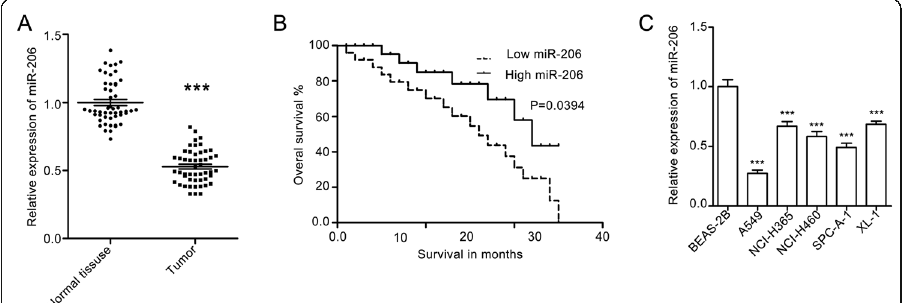
Fig. 1 MiR-206 expression is downregulated in NSCLC tissues and cell lines. a The miR-206 mRNA level in NSCLC tissues and the corresponding normal mucosa tissues detected by q-RT-PCR assay. Quantitative data are presented as the mean ± SEM, n = 50. * **P < 0.001 compared with the normal tissues. b Kaplan – Meier curves for overall survival analysis based on miR-206 expression. c miR-206 expression in human lung epithelia BEA-2B cells and human lung cell lines, including A549, NCI-H365, NCI-H460, SPCA-1 and XL-1, detected with q-RT-PCR assay. Quantitative data are presented as mean ± SEM, n = 50. * **P < 0.001 compared with BEA-2B